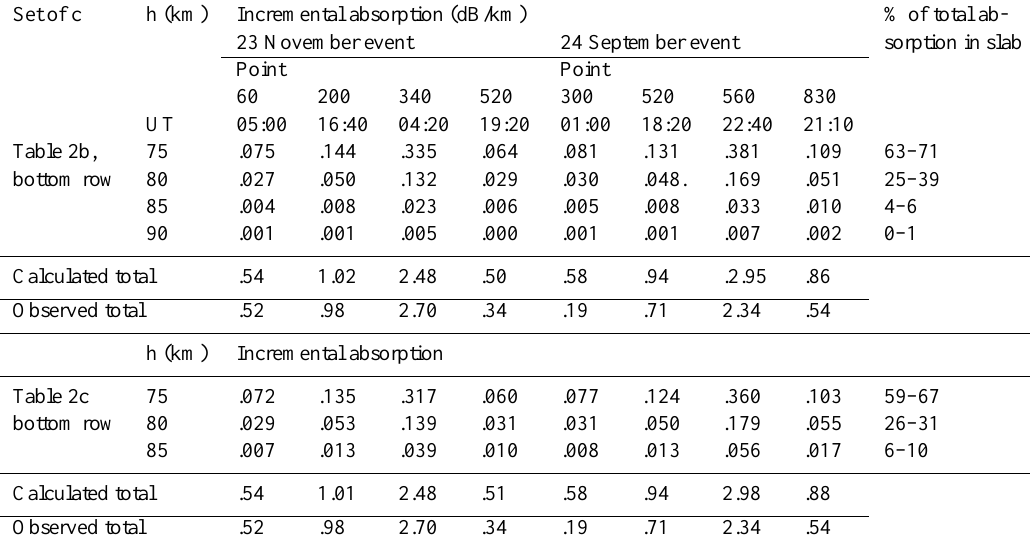
Table 3. Distribution of absorption with height at selected times in the November and September events, using coefficients from Tables 2b and c. Set of c